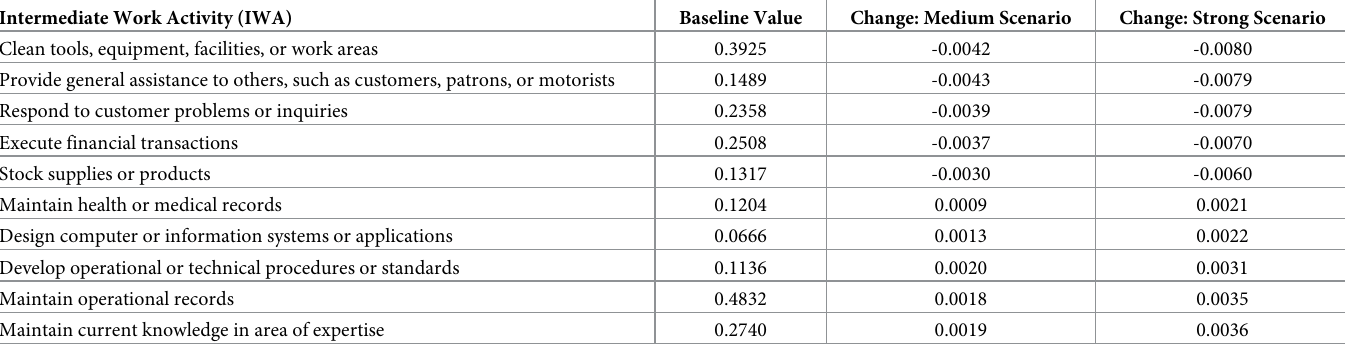
Table 3. Projected changes in fraction of workforce engaged in Intermediate Work Activities